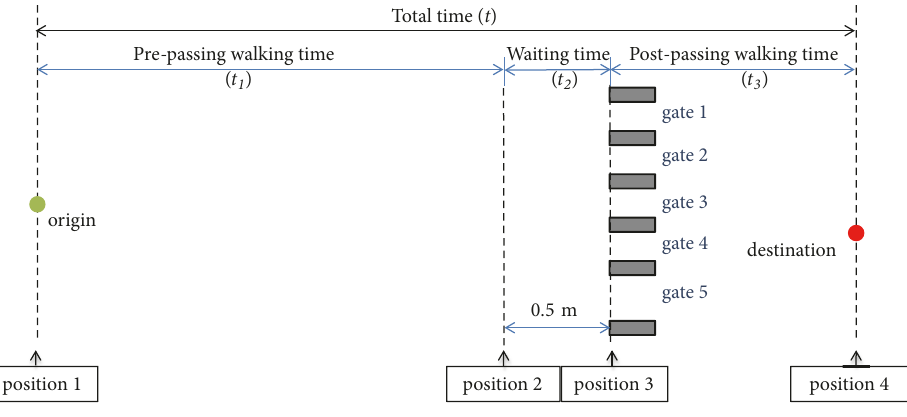
Figure 11: Measurement positions and travel